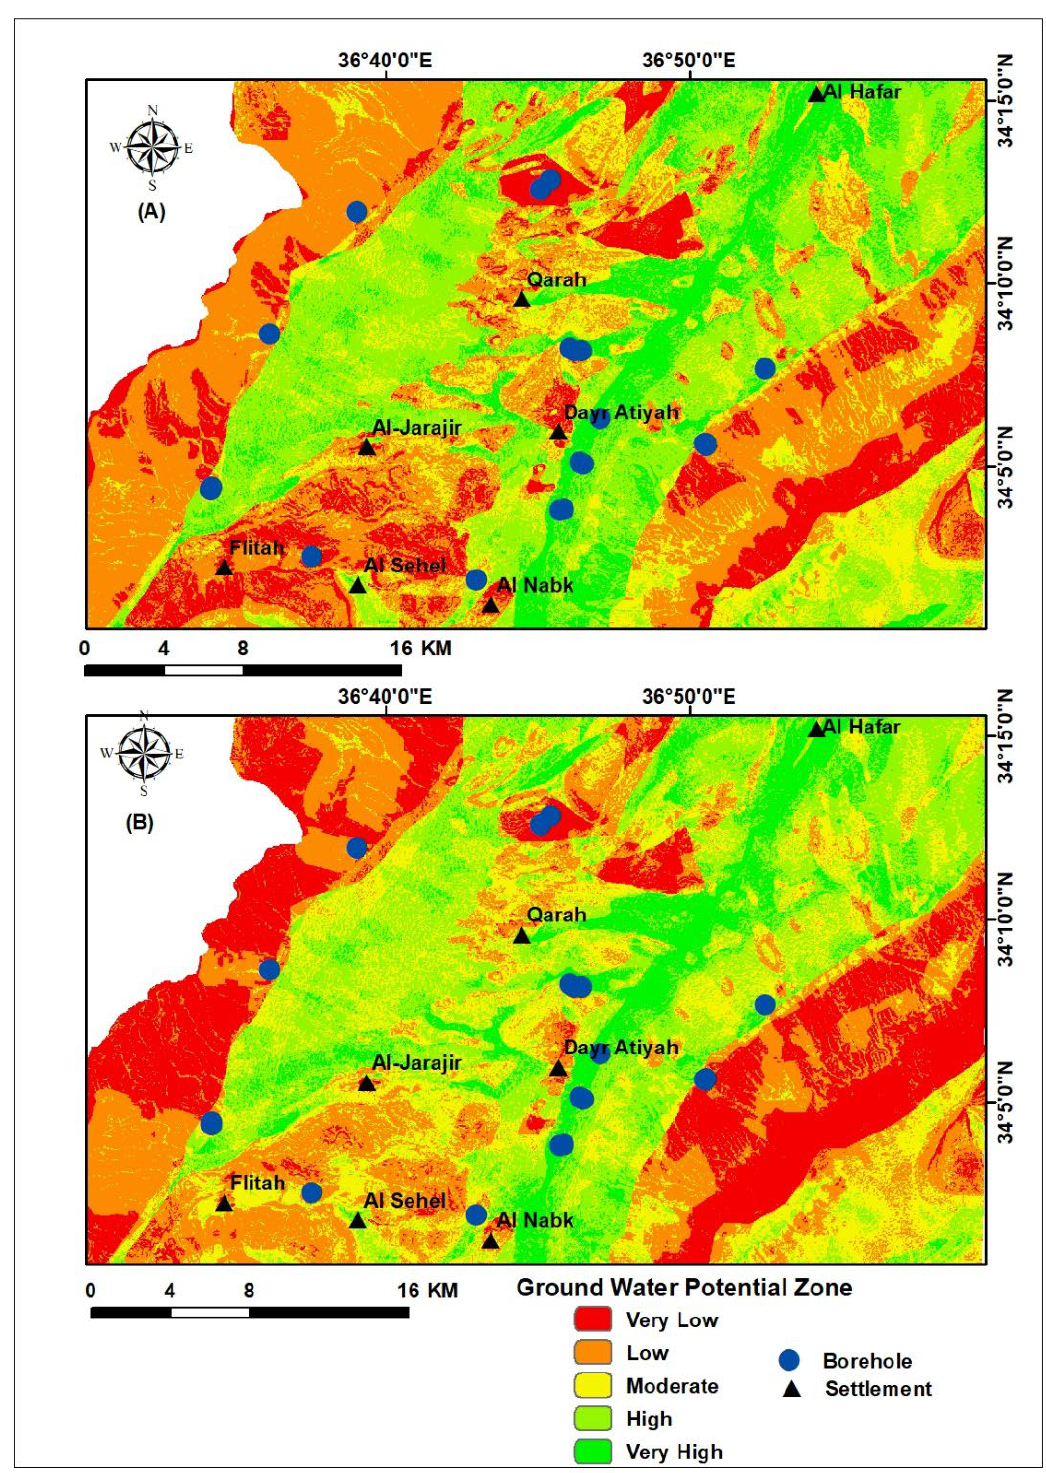
Figure A4. Groundwater Potential Zone of the ( A ) AHP4 and ( B ) MIF4 maps.